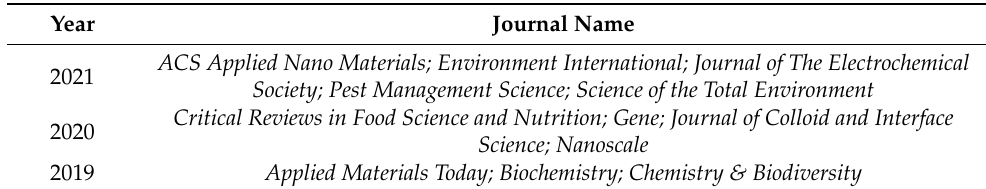
Table 2. List of journals that have appeared in the co-occurrence network in the last three